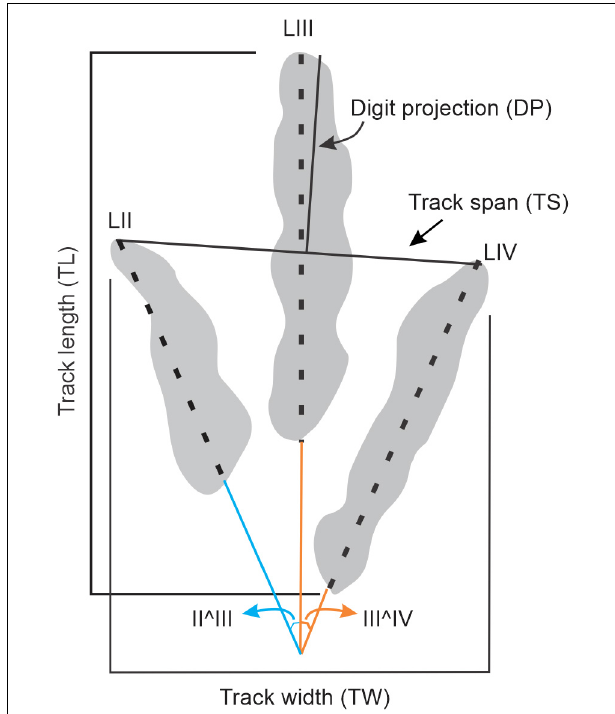
FIGURE 2 | Parameters measured from tridactyl tracks in the field or using ImageJ software (Schneider et al., 2012). LII–LIV – respective digit lengths; IIˆIII, IIIˆIV – respective interdigit